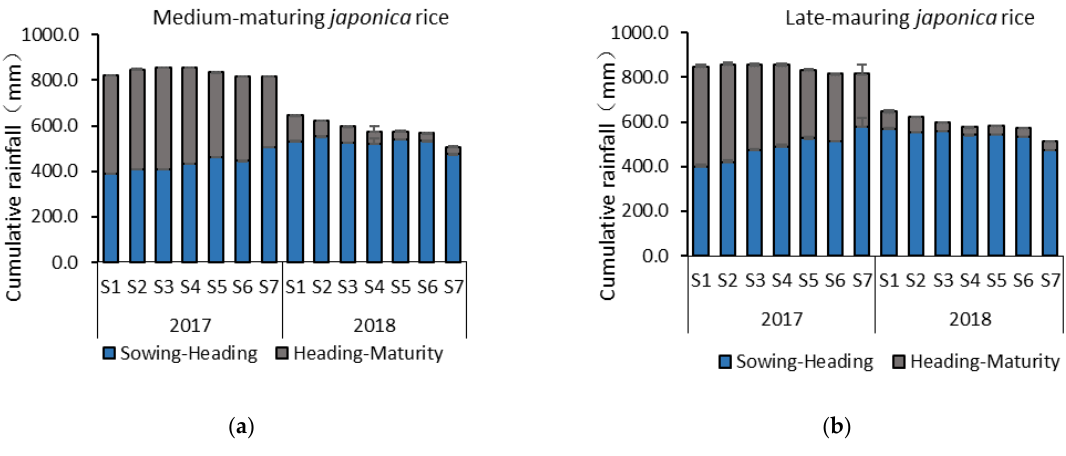
Figure 5. Difference of the accumulated rainfall (CR) under different sowing dates. ( a ): Medium-maturing japonica rice; ( b ): Late-maturing japonica rice.